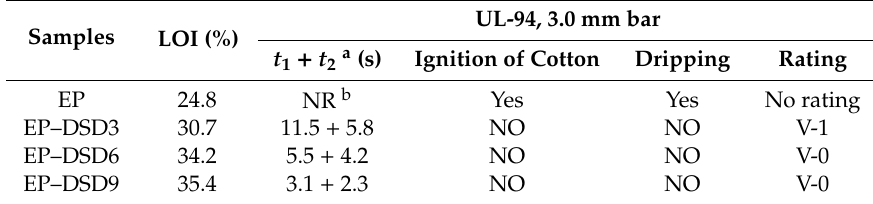
Table 2. Flame-retardancy of EP and EP–DSD thermosets.